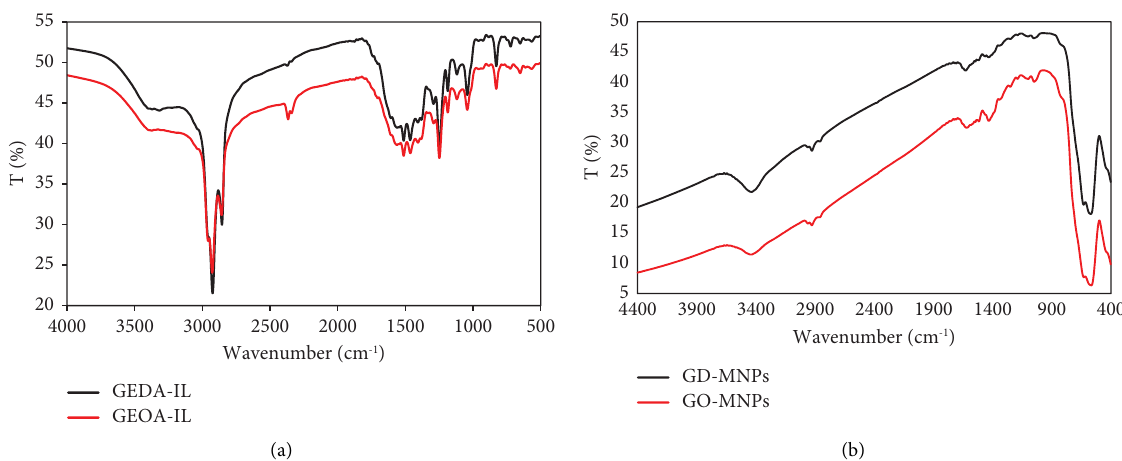
Figure 1: FTIR spectra of (a) ILs, GEDA-IL and GEOA-IL, and (b) MNPs, GD-MNPs and GO-MNPs.